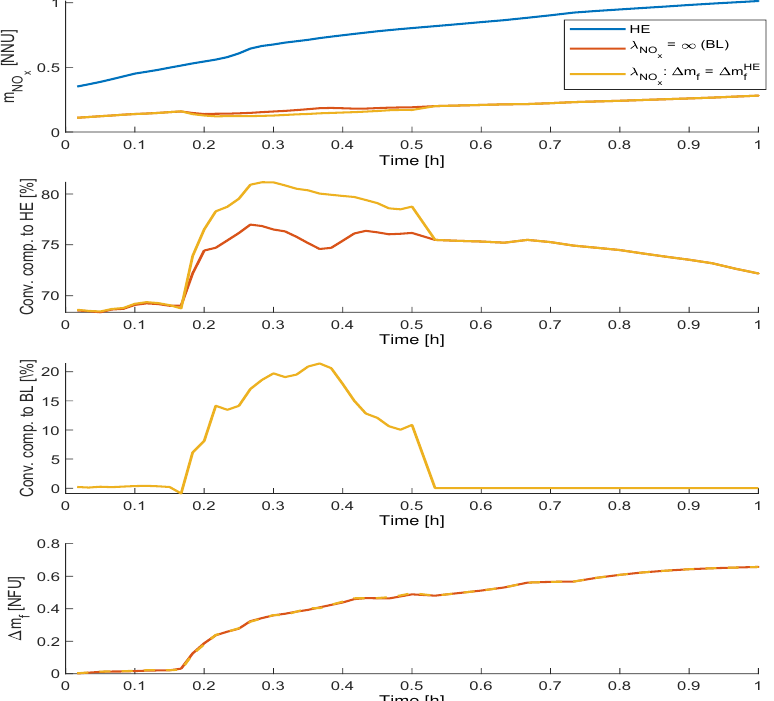
Figure 8. Results from simulations of the single-event cycle with varying length of engine-off event. The figure includes results from the high-efficiency (HE) mode, the baseline strategy ( λ NO and simulations where λ NO has been chosen such that the fuel consumption is the same as for the x baseline